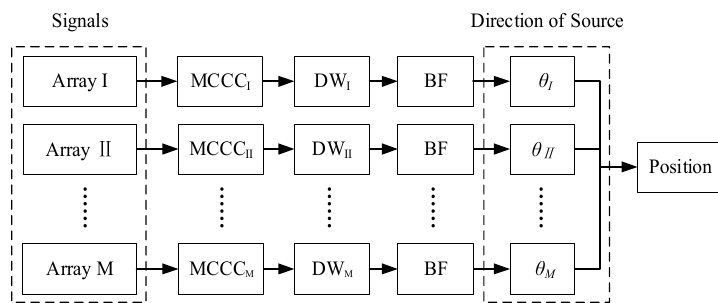
Figure 1. Positioning flowchart.